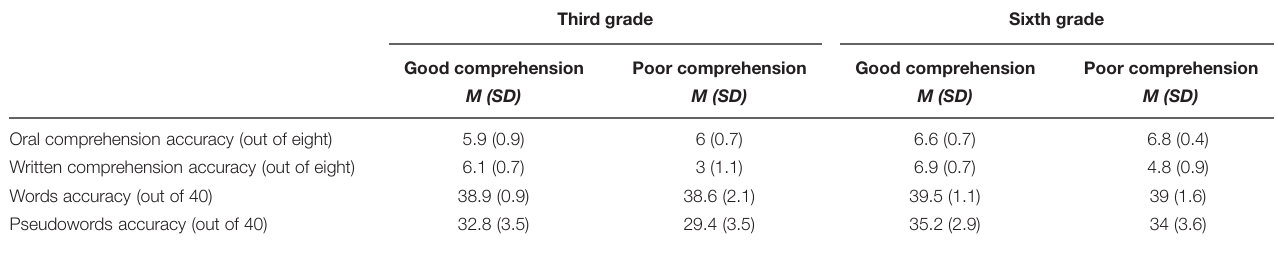
TABLE 2 | Results in PROLEC-R test and comprehension questions of